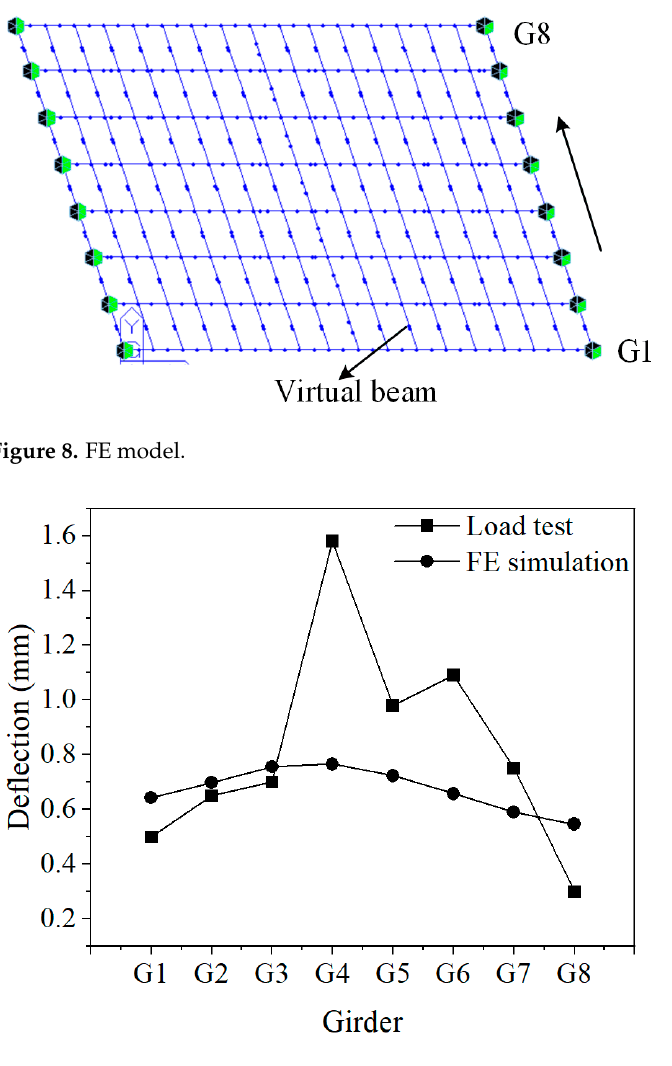
Figure 9. Mid-span de fl ection of each girder.